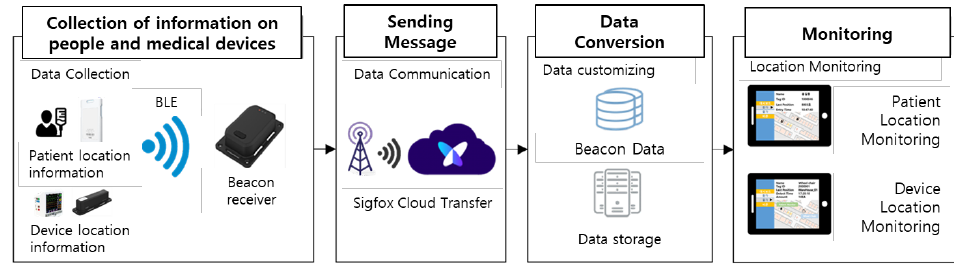
Figure 5. Monitoring System using Sigfox in a Hospital Test setting.